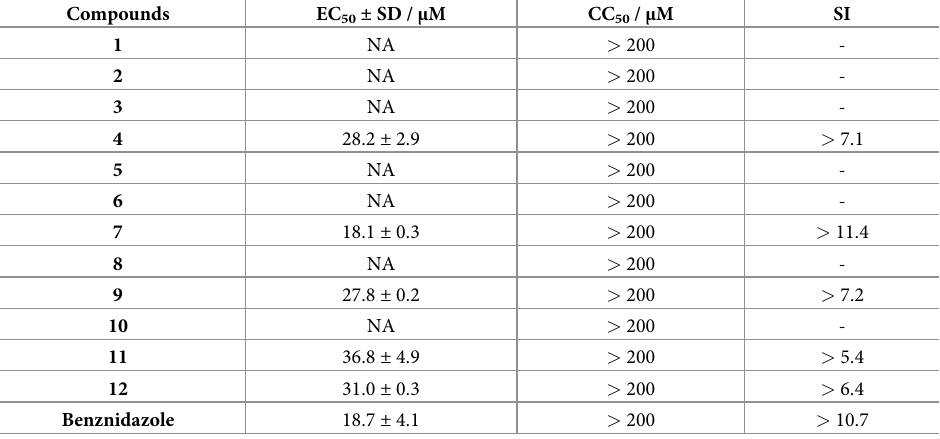
Table 2. Anti- Trypanosoma cruzi activity of the compounds 1–12 isolated from the twigs and leaves of Nectandra oppositifolia and positive control benznidazole.